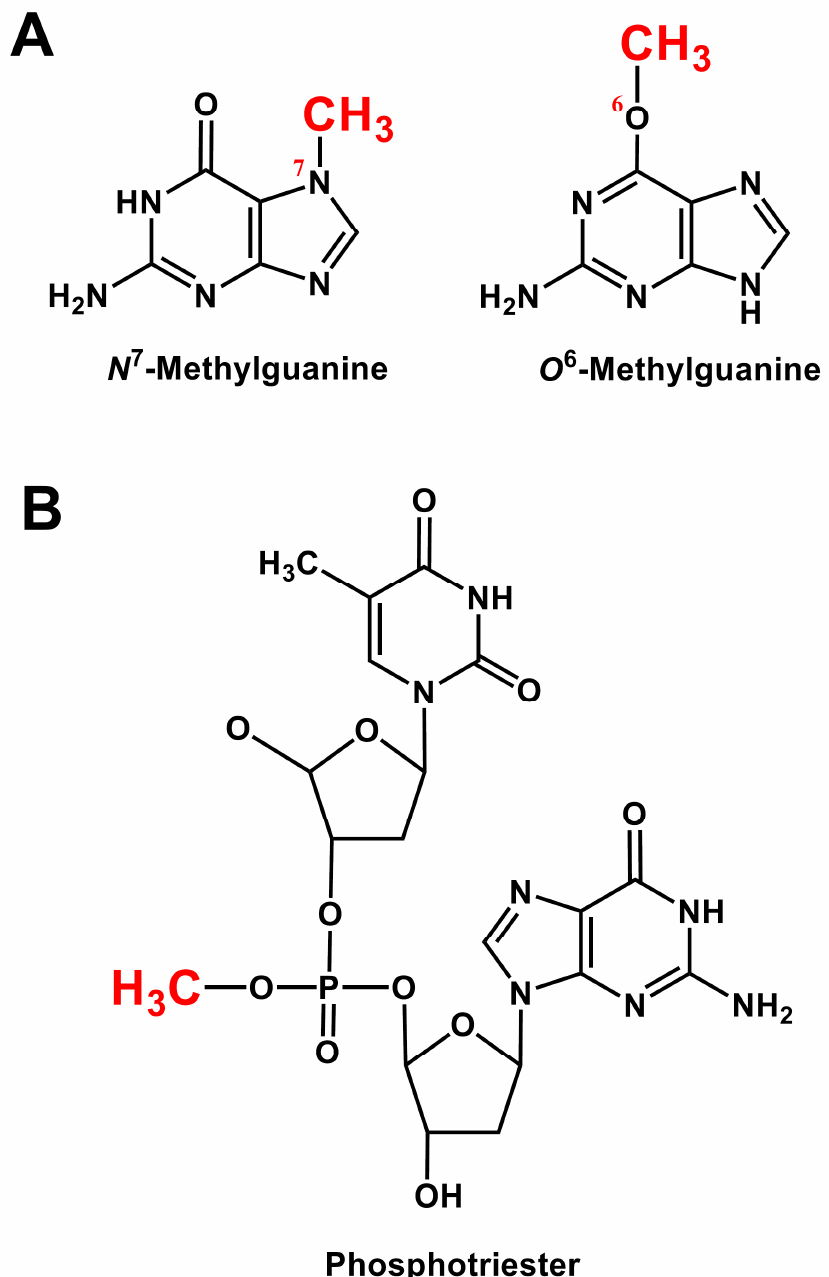
Figure 4. Methylation by the STZ breakdown product carbonium ion of the guanine bases contained in cellular DNA and RNA at the N 7 and O 6 positions ( panel A ) and of the DNA’s phosphate backbone ( panel B ).